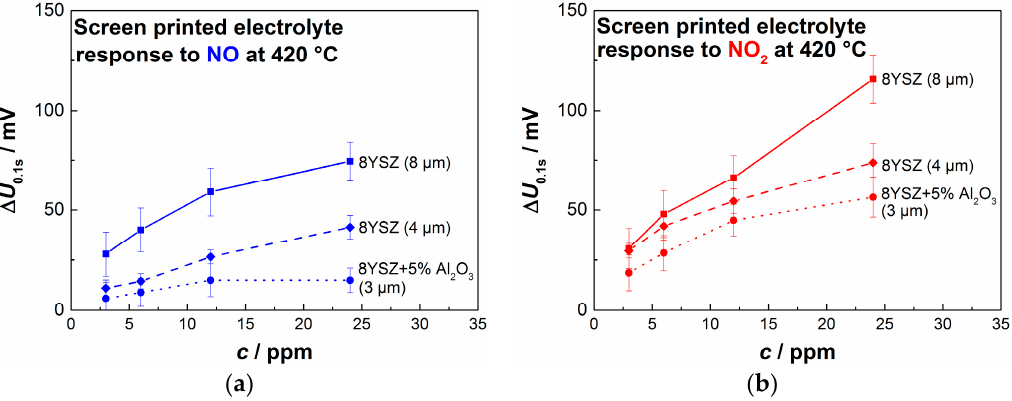
Figure 11. Sensor responses for sensors based on 8YSZ electrolytes built by screen-printing and sintering with overlying platinum electrodes towards small concentration of ( a ) NO and ( b ) NO 2 . Again, the concentration of NO and NO 2 has a semi-logarithmic dependency on ∆ U .